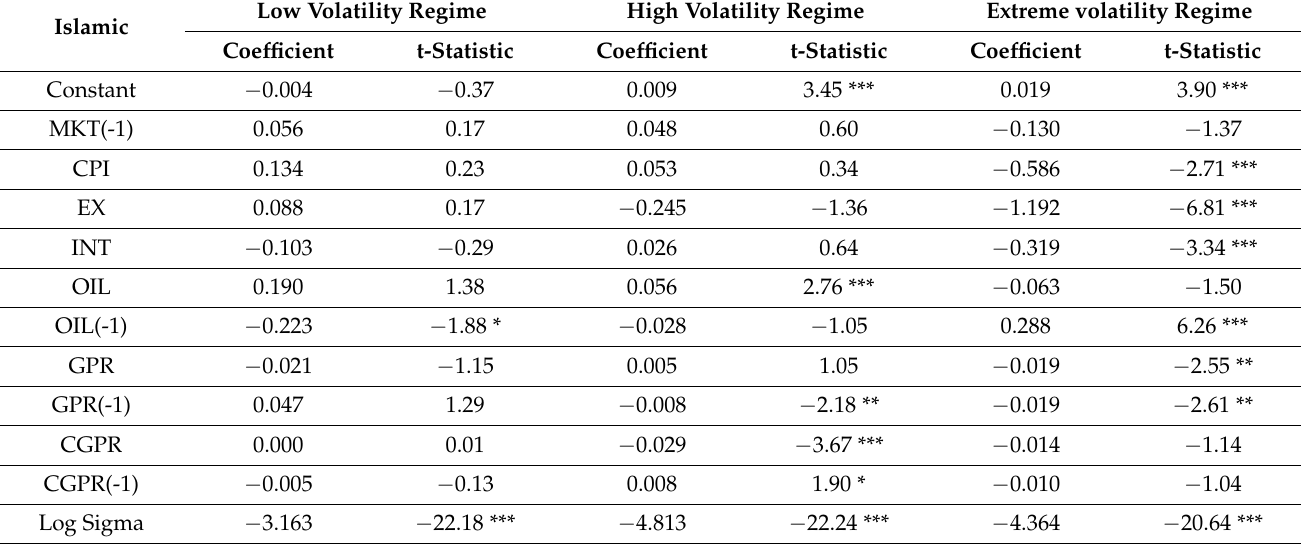
Table 4. Results of Regime Switching Regression for Islamic Stock